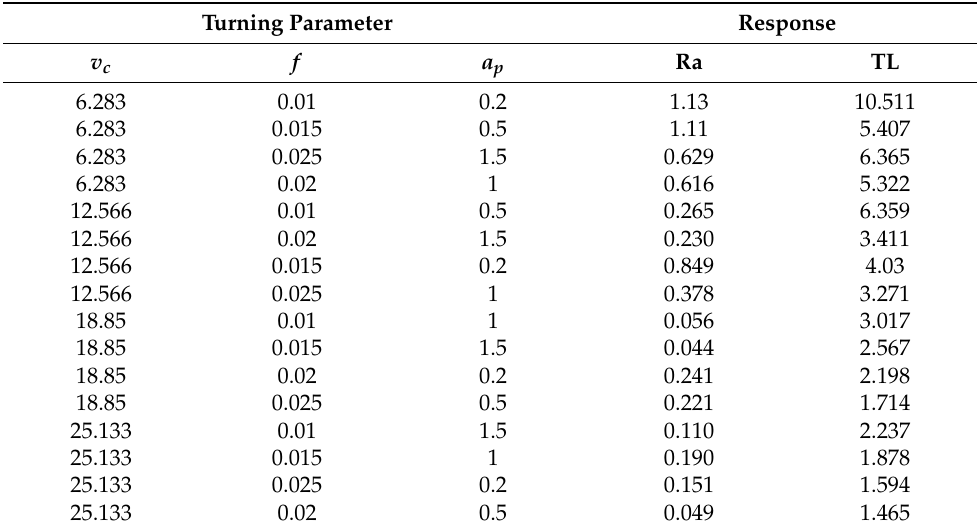
Table 2. Turning parameters and measured responses [20]. Turning